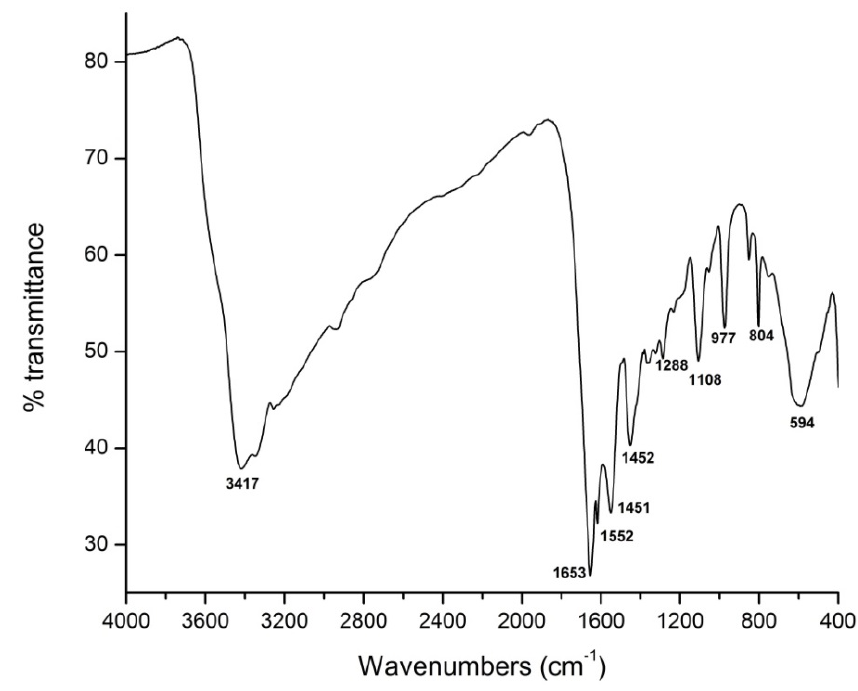
Figure 1. Fourier transform infrared spectroscopy (FTIR) spectra of the ferric